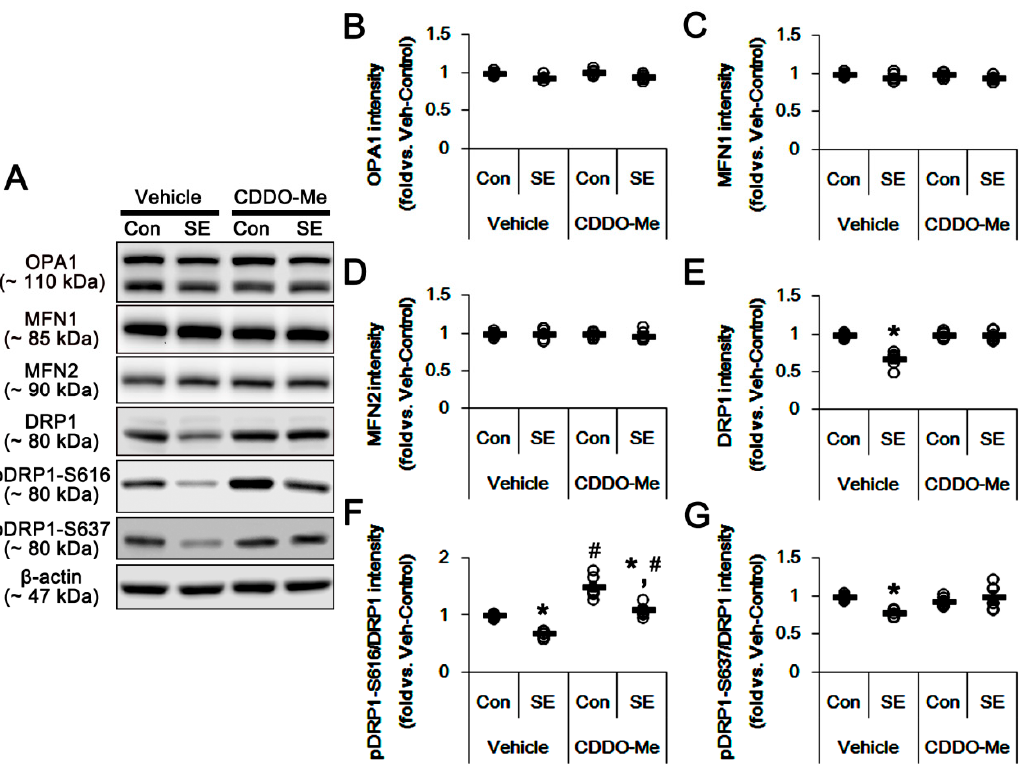
Figure 4. Effects of CDDO-Me on the expression and phosphorylation of mitochondrial dynamics-related molecules. CDDO-Me increases only the dynamin-related proteins 1 (DRP1)-S616 phosphorylation level under physiological- and post-SE conditions. ( A ) Representative images for western blots of optic atrophy 1 (OPA1), mitofusin 1 (MFN1), MFN2, DRP1, phospho (p)-DRP1-S616 and pDRP1-637 in the hippocampal tissues. ( B – G ) Quantifications of OPA1, MFN1 and MFN2, DRP1, pDRP1-S616 and pDRP1-637 levels. Open circles indicate each individual value. Horizontal bars indicate mean value. Error bars indicate SEM (*, # p < 0.05 vs. control animals and vehicle, respectively; n = 7, respectively).